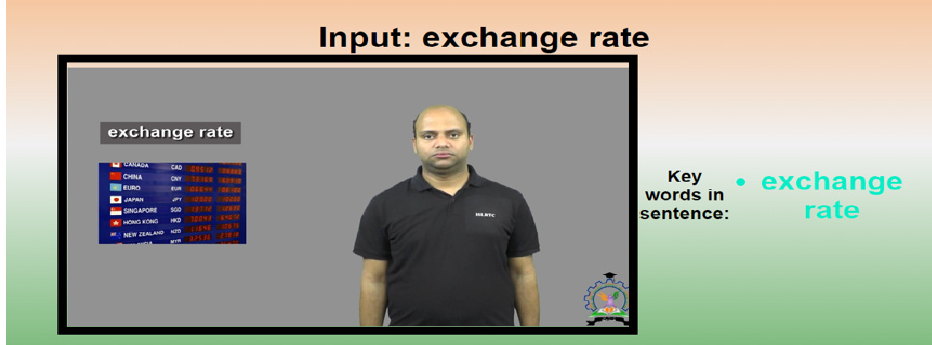
Figure 12. Case 4. Available video for ‘exchange rate’.